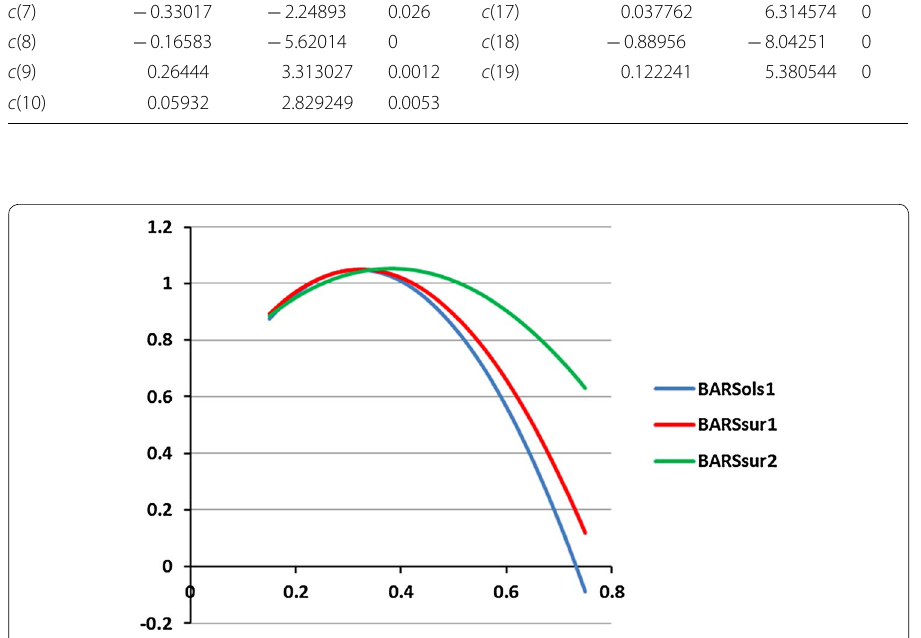
Fig. 6 Static BARS